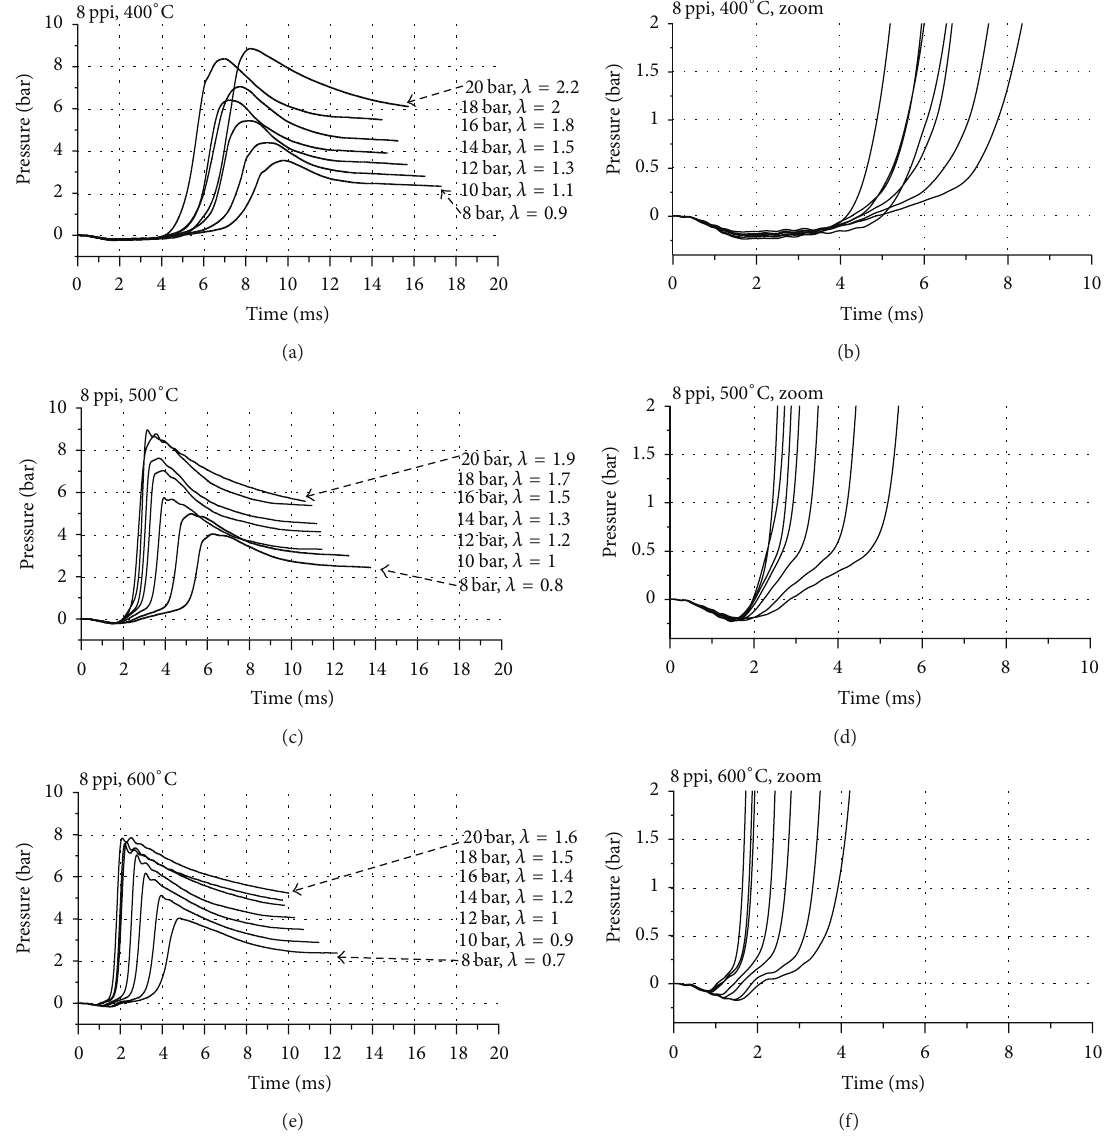
Figure 6: Pressure history for heat release in an SiC foam porous reactor (8ppi) after fuel injection starts at three initial reactor temperatures 400 ∘ C, 500 ∘ C, and 600 ∘ C for different initial pressures from 8bar to 20bar. The amount of injected fuel is 23.7 mg, and air excess ratio is not constant 𝜆 = 𝑓(𝑝) ; left—complete history; right—initial period of the